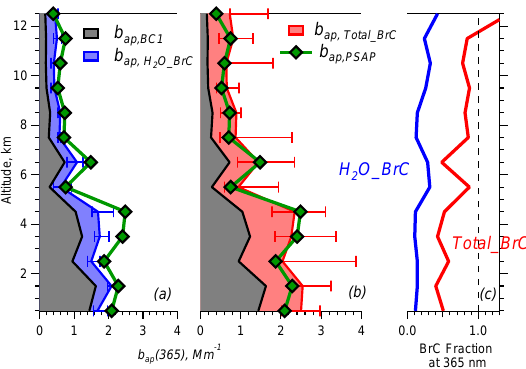
Figure 7. Vertical profiles of estimated aerosol optical absorption at 365nm by BrC, BC, determined by an extrapolation from PSAP absorption at 660nm ( b ap,BC1 shown in the schematic), and the sum of BrC and BC compared to total light absorbing determined from the PSAP data. (a) shows water-soluble BrC (blue shaded), (b) the total BrC (red shaded), and (c) relative contribution of BrC to total aerosol absorption. In all plots, median values are shown and error bars indicate the inter-quartile range of estimated BrC absorption for each 1km altitude bin. (Measurement uncertainties of the var- ious absorption coefficients are estimated to be between ± 28 and ± 45%). Only background tropospheric data are